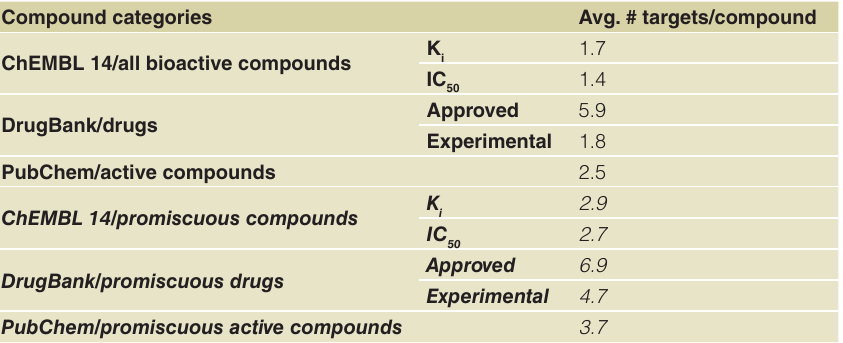
Table 1. Average promiscuity of different compound